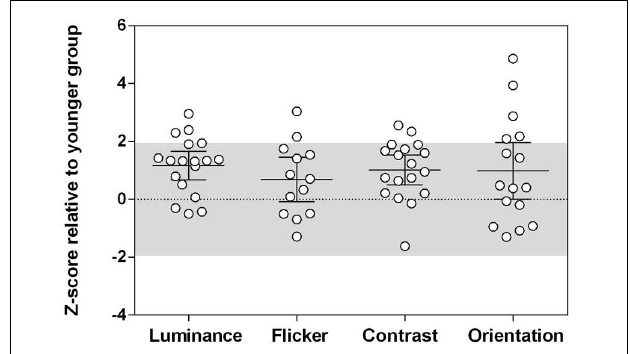
FIGURE 4 | The magnitude of contextual effects across different tasks in older observers. Z -scores were calculated relative to the younger group performance. The shaded area is where 95% of the younger participants’ data lies (1.96 standard deviations from the mean). Positive z -scores indicate stronger suppression relative to the younger group mean, taking into account task variability. Error bars are the 95% confidence limits of the mean. There was no group difference in Z -scores across all tasks, F (3,98.15) = 0.23, p = 0.87.